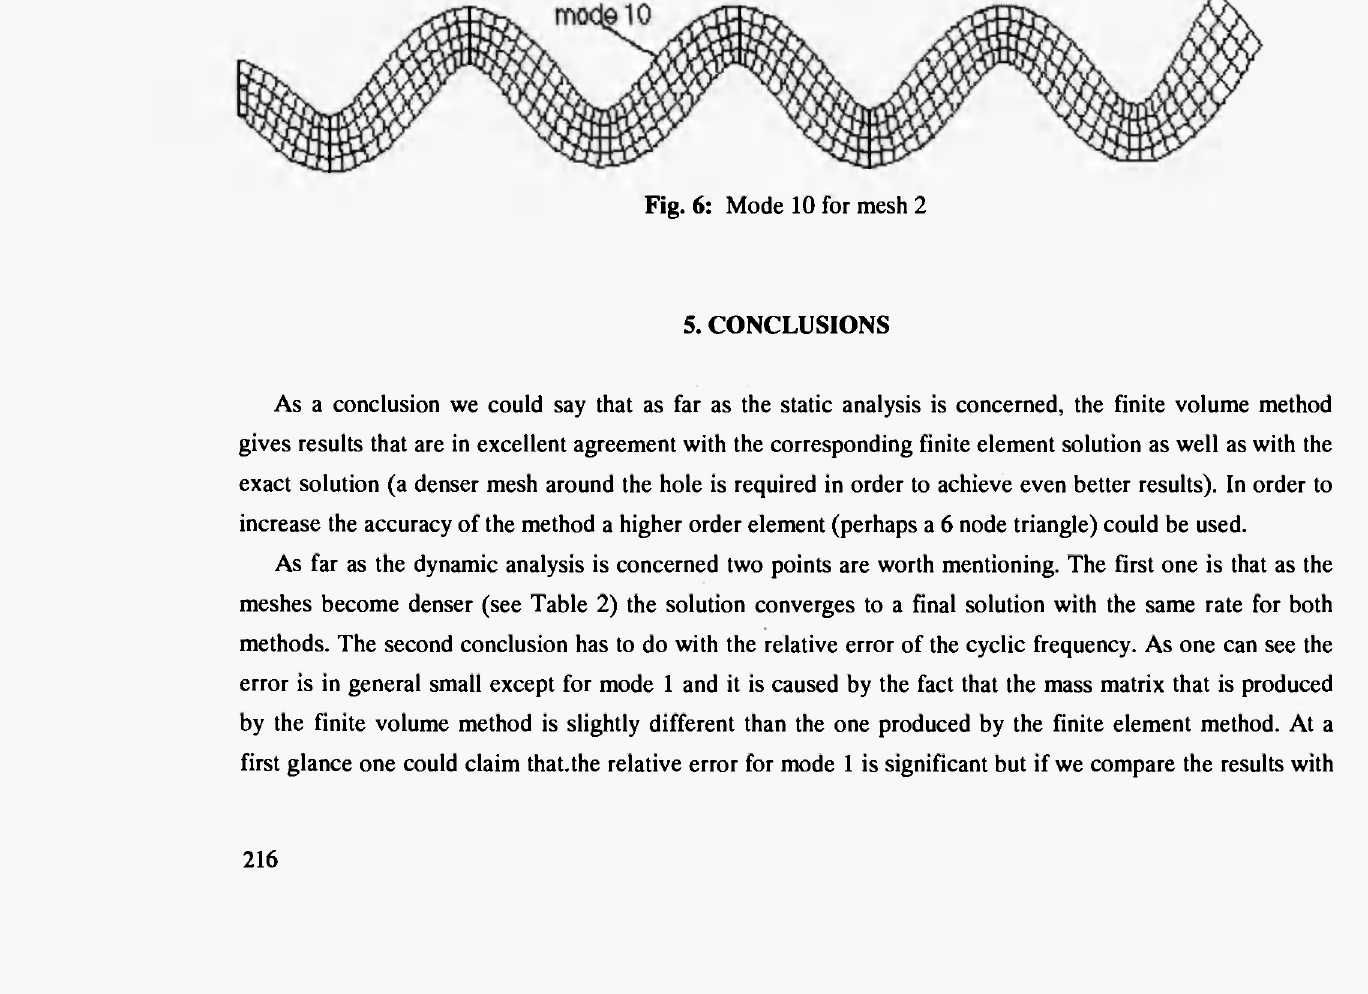
Fig. 6: Mode 10 for mesh